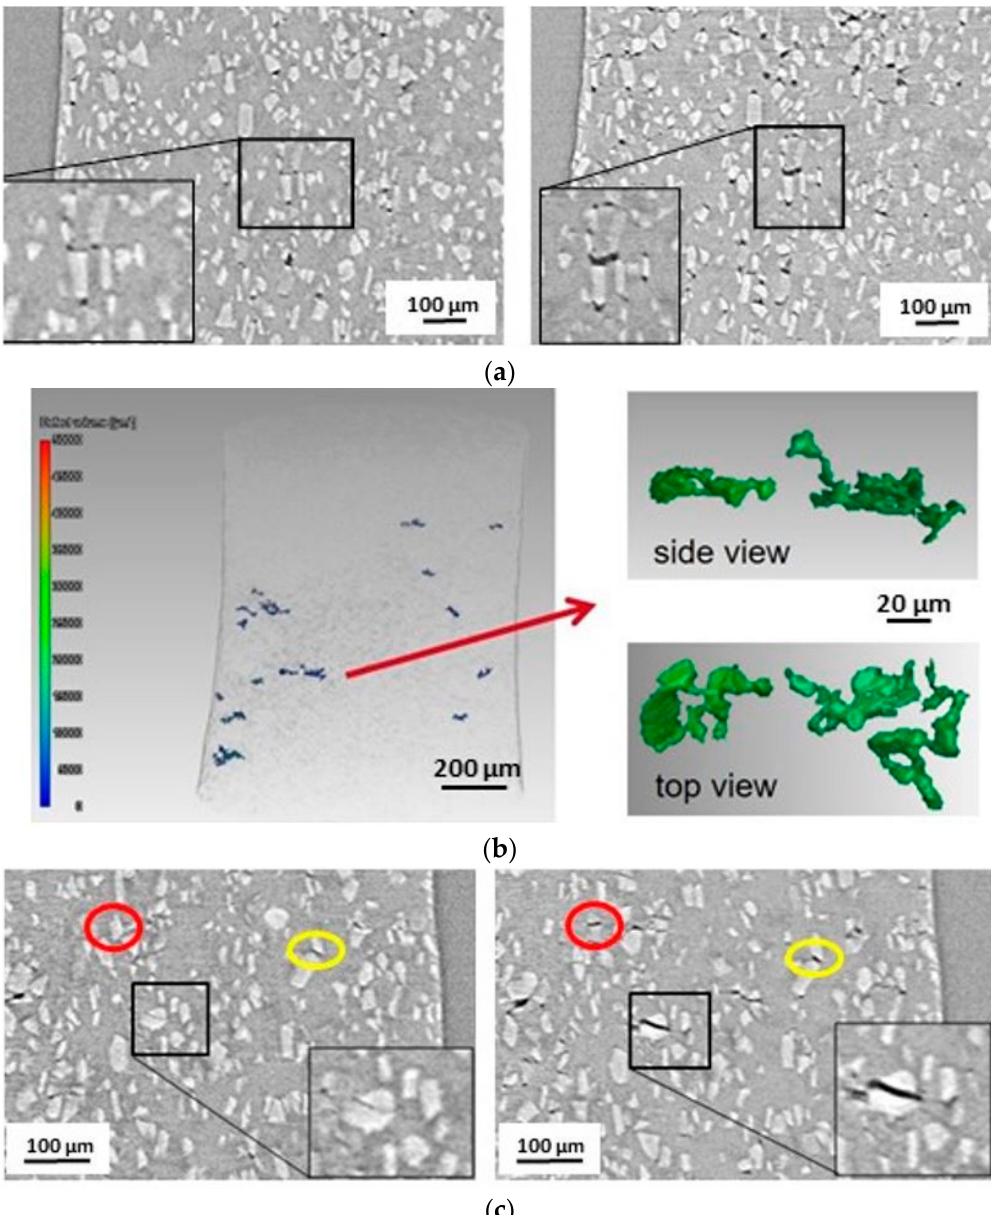
Figure 17. Al-MMC, creep damage, longitudinal section: ( a ) 2D, surface diffusion, σ = 50 MPa, T = T = 300 ◦ C, left: 0.77 t fr , right: 0.98 t fr ; ( b ) 3D, surface di ff usion, σ = 50 MPa, T = 300 ◦ C, 0.98 t fr ; 300 °C, left: 0.77 𝑡 (cid:3033)(cid:3045) , right: 0.98 𝑡 (cid:3033)(cid:3045) ; ( b ) 3D, surface diffusion, σ = 50 MPa, T = 300 °C, 0.98 𝑡 (cid:3033)(cid:3045) ; ( c ) ( c ) particle fracture, σ = 190 MPa, T = 200 ◦ C, left: 0.03 t fr , right: 0.98 t fr particle fracture, σ = 190 MPa, T = 200 °C, left: 0.03 𝑡 (cid:3033)(cid:3045) , right: 0.98 𝑡 (cid:3033)(cid:3045) .